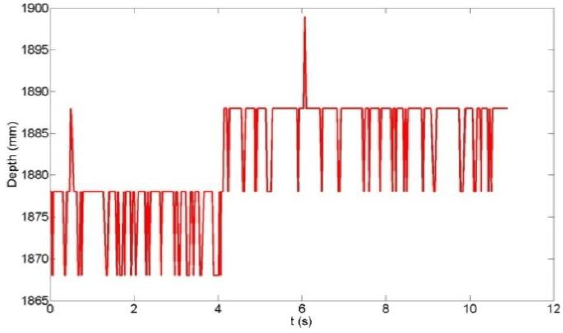
Figure 5. Raw Microsoft Kinect depth measurement at the witness plate centroid.